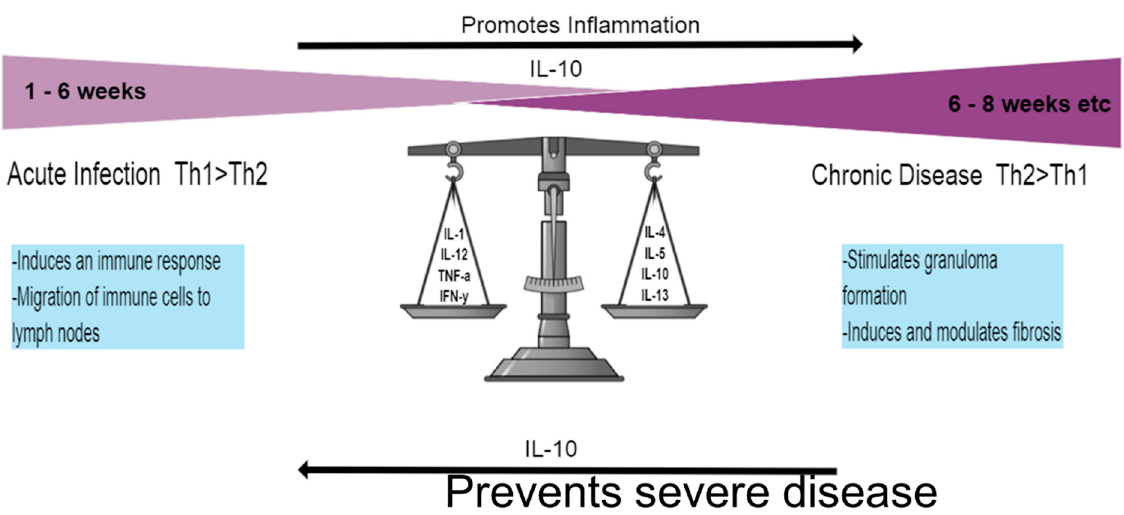
Figure 1. Th1 and Th2 responses. The initial response once infected by the schistosome parasite lasts for ~6 weeks and is dominated by the Th1 response, characterized by pro-inflammatory cytokines. Once the adult worms lay eggs and release SEA, the Th2 response sets in, largely driven by IL-4 and IL-13. Chronic disease requires formation of the granuloma and digresses into liver fibrosis. The Il-10 cytokine represents an important element in disease progression by encouraging inflammation through down-regulation of the Th1 response but also preventing severe disease during the Th2 response.